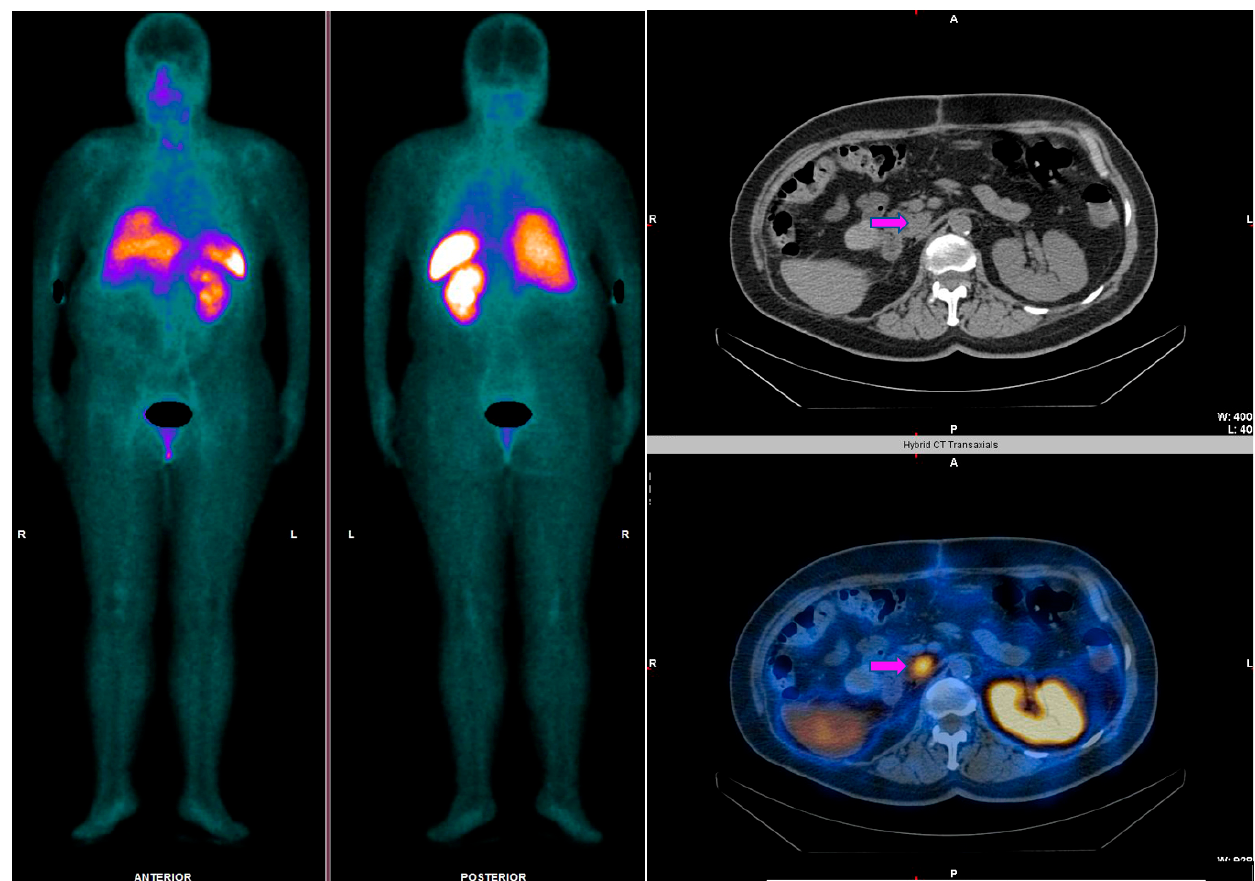
Figure 4. A 69-year-old female patient who underwent 99m Tc-EDDA/HYNIC-TOC SRS for biochemical suspicion of NET (high values of seric Chromogranin A). The scan revealed increased uptake in the uncinate process of the pancreas (arrow). The histopathological examination from the subsequent excision of the mass proved to be negative for NET.